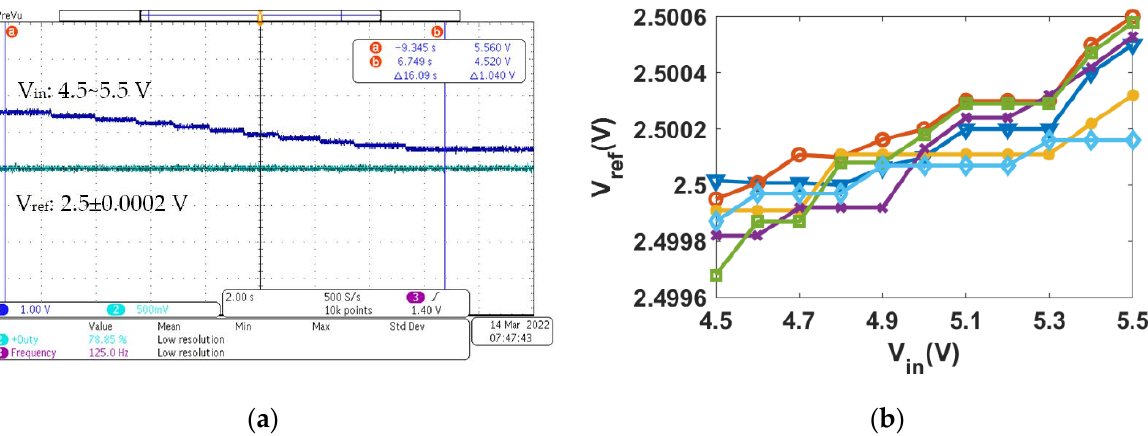
Figure 12. Measured reference voltage versus supply voltage: ( a ) oscilloscope monitoring results; ( b ) six chip measurement results.